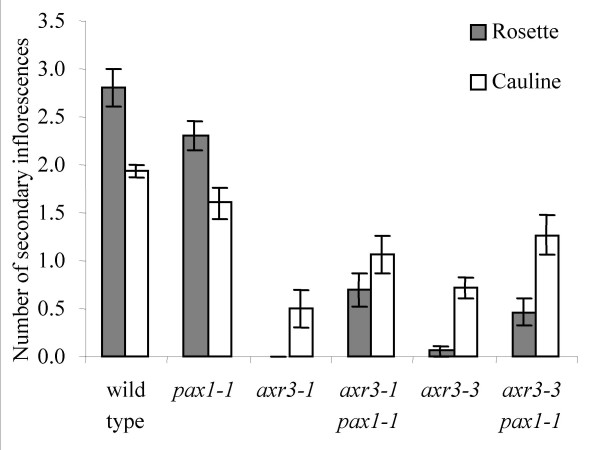
Shoot branching phenotypes of axr3 pax1-1 double mutants. Numbers of secondary inflorescences arising from rosette and cauline nodes following flowering. n ≥ 8. Error bars represent SE.